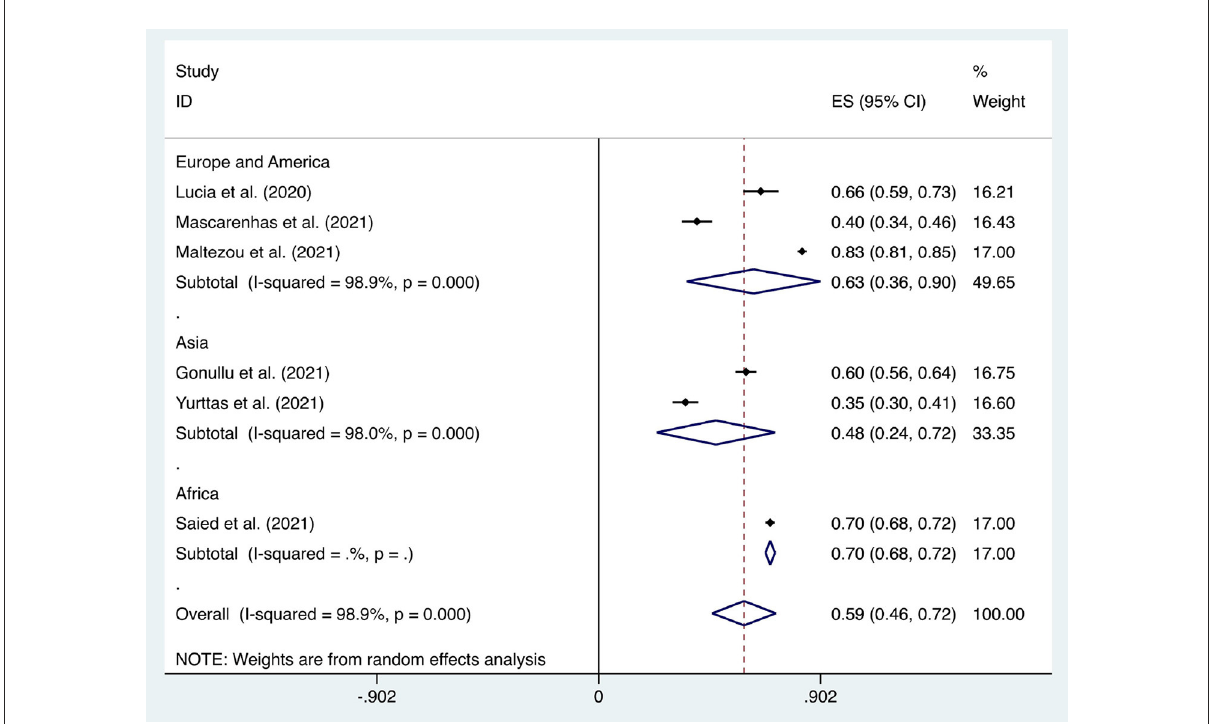
FIGURE3 Forest plot of the acceptance of healthcare workers of compulsory vaccination.